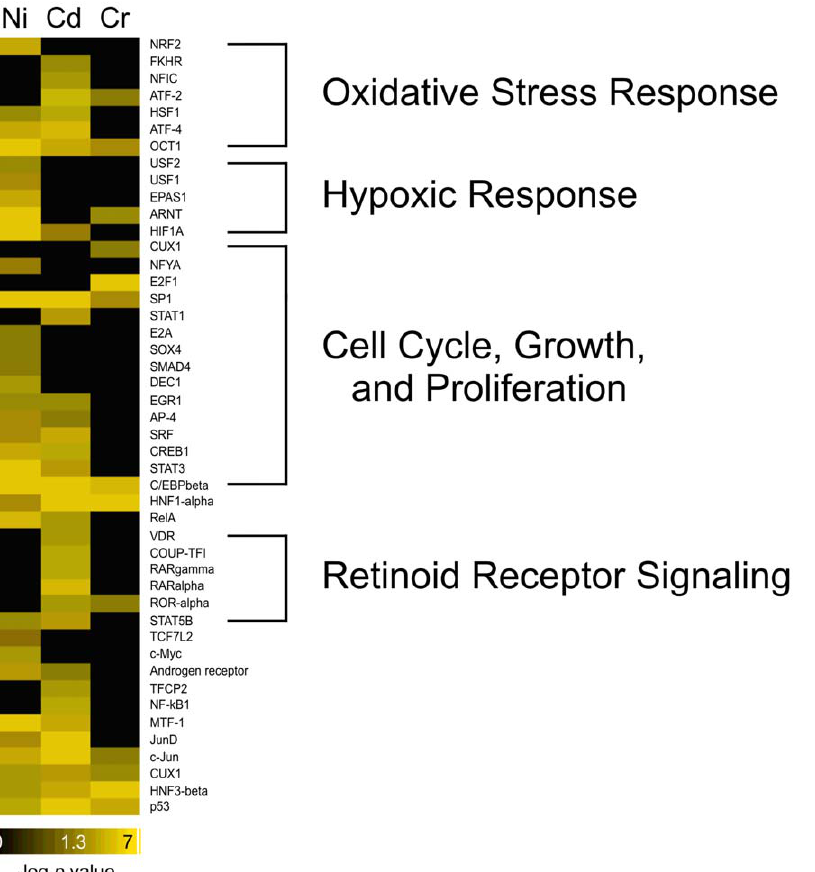
Figure 2. Transcription factor enrichment analysis. Enrichment analysis conducted using MetaCore shows transcription factors whose targets are overrepresented in the differentially expressed gene lists. Transcription factors involved in the oxidative stress response, hypoxic response, cell cycle, cell growth and proliferation, and retinoic acid signaling were enriched. The values are presented as the –log of the p-value.